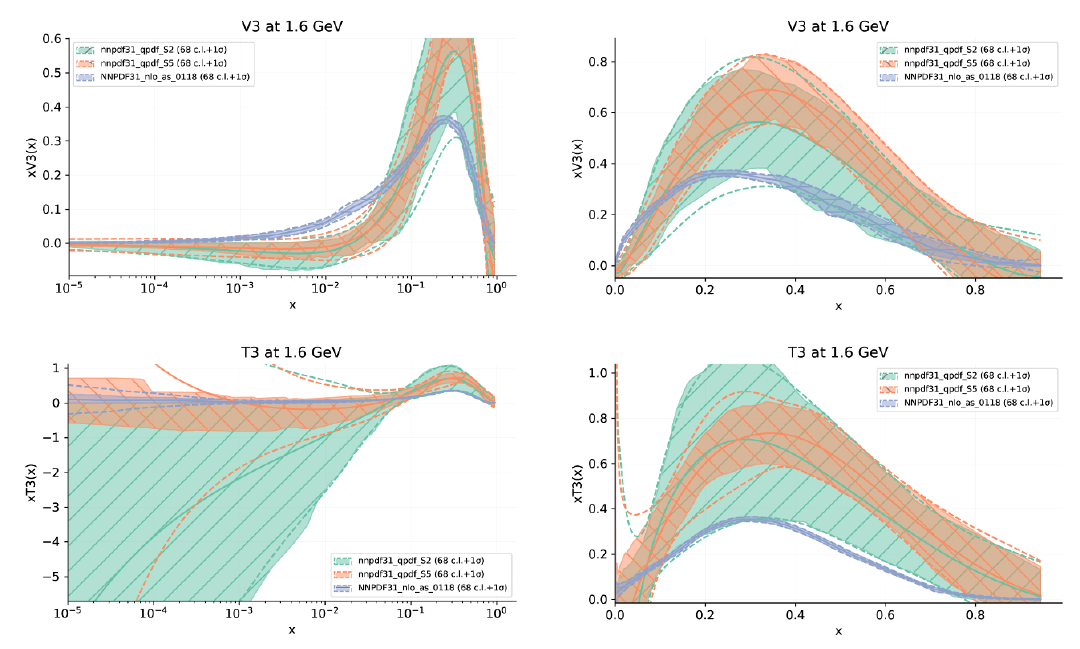
Figure 6 . S2 vs. S5: S2 results are more conservative than the S5 ones, showing also a small shift of the replica 0 towards the light-cone PDFs. Overall, S2 results are comptible with NNPDF31 nlo 0118 within 1-sigma level.